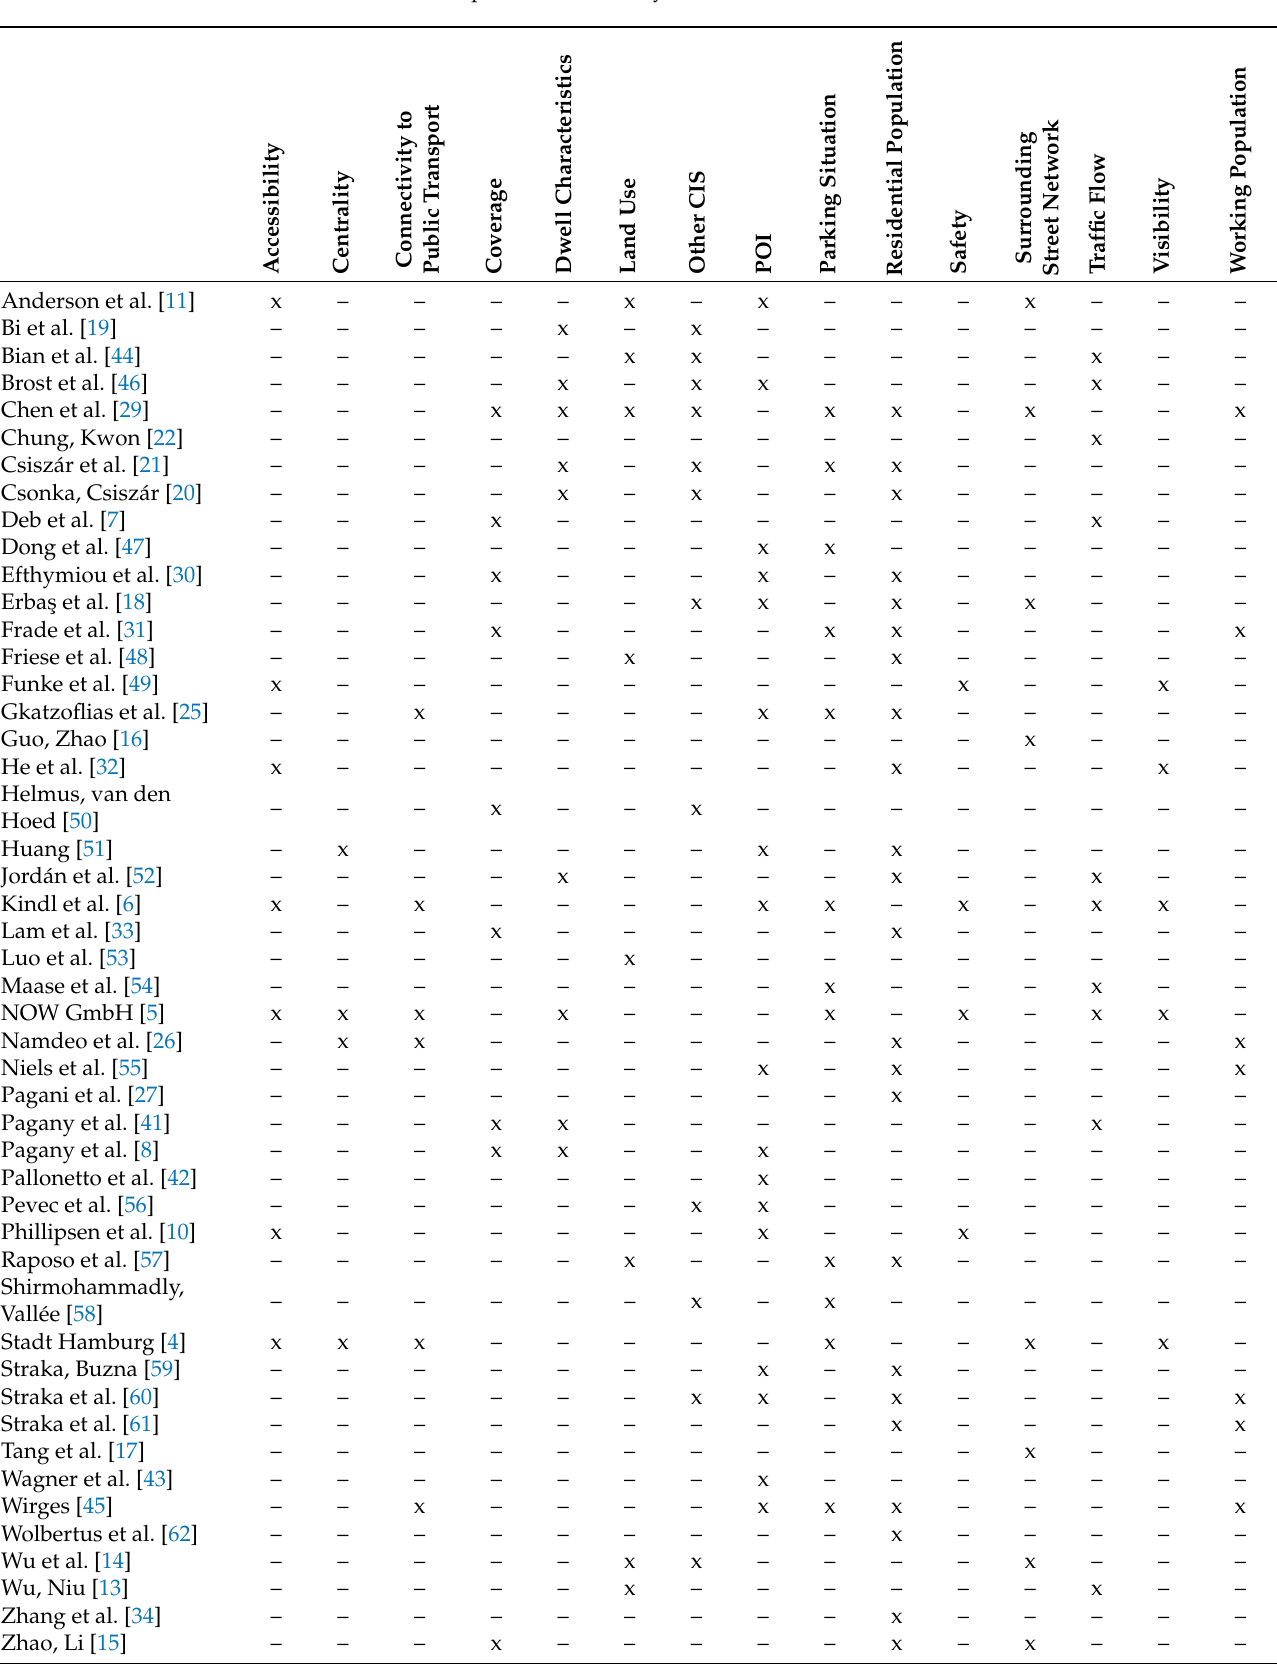
Table 2. Core aspects mentioned by